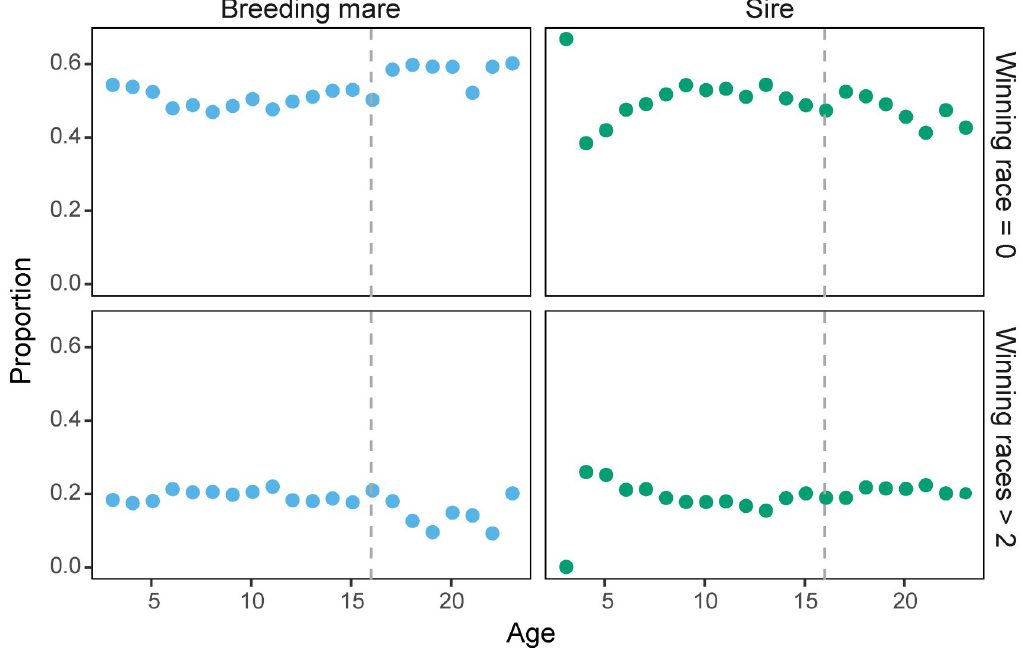
Fig 2. Relationship between the racing performance of offspring and parents’ age. The upper row shows the proportion of offspring which did not win any races. In the lower row the proportion of offspring which won more than two races are drawn. The dashed line indicates 16 years old, which was determined as a threshold of age category. This figure contains results for parents over the age of 3 and under the age of 24. A figure including all data is shown in SI 2 in S1